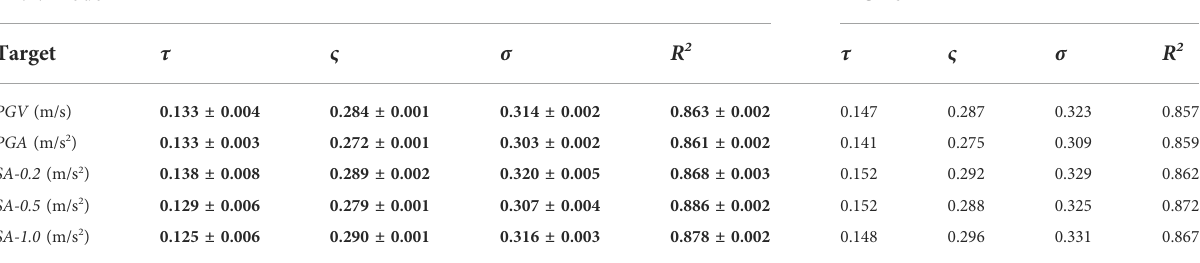
TABLE2PerformanceresultsoftheproposedANNmodelandMOD3ofSharmaetal.(2013)usingthedatasetofTheGeysersgeothermalregion.The results are expressed in terms of mean ± standard deviation for the ANN model. The best results are reported in bold.